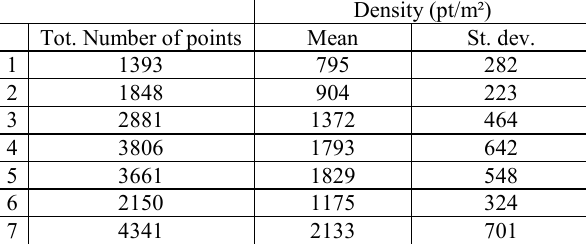
Figure 7. Sample A, Sections.